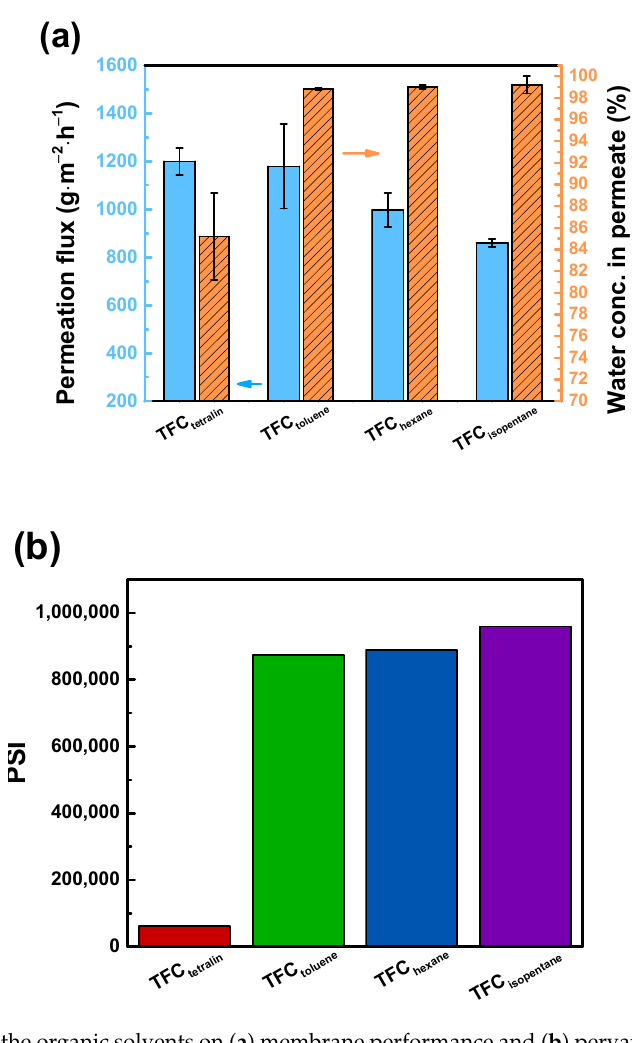
Figure 6. E ff ect of the organic solvents on ( a ) membrane performance and ( b ) pervaporation separation index. Feed = 90 wt% aqueous ethanol solution at 25 ◦ C. Downstream pressure = 13 mmHg.